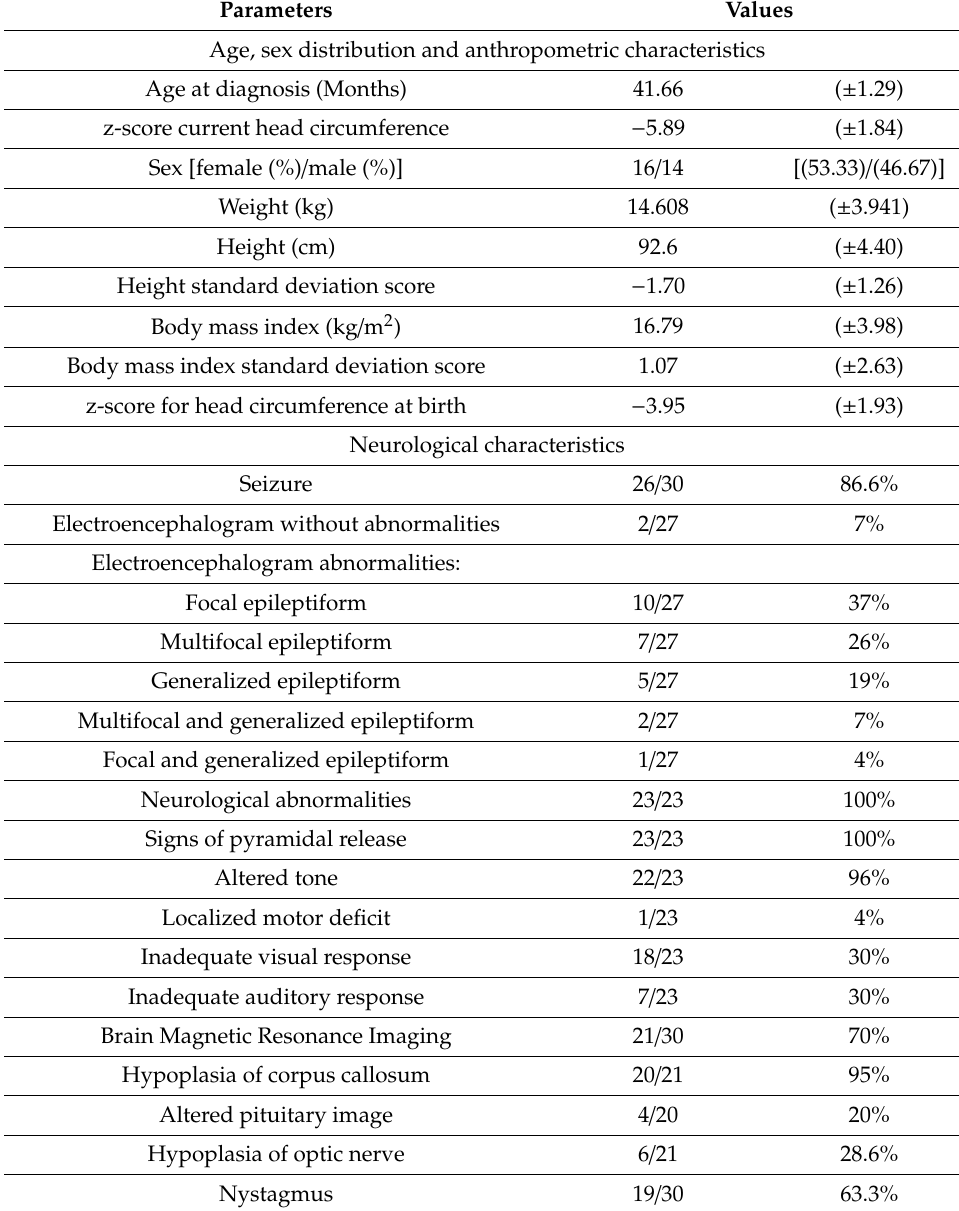
Table 1. Neurological characteristics, age, sex distribution and anthropometric